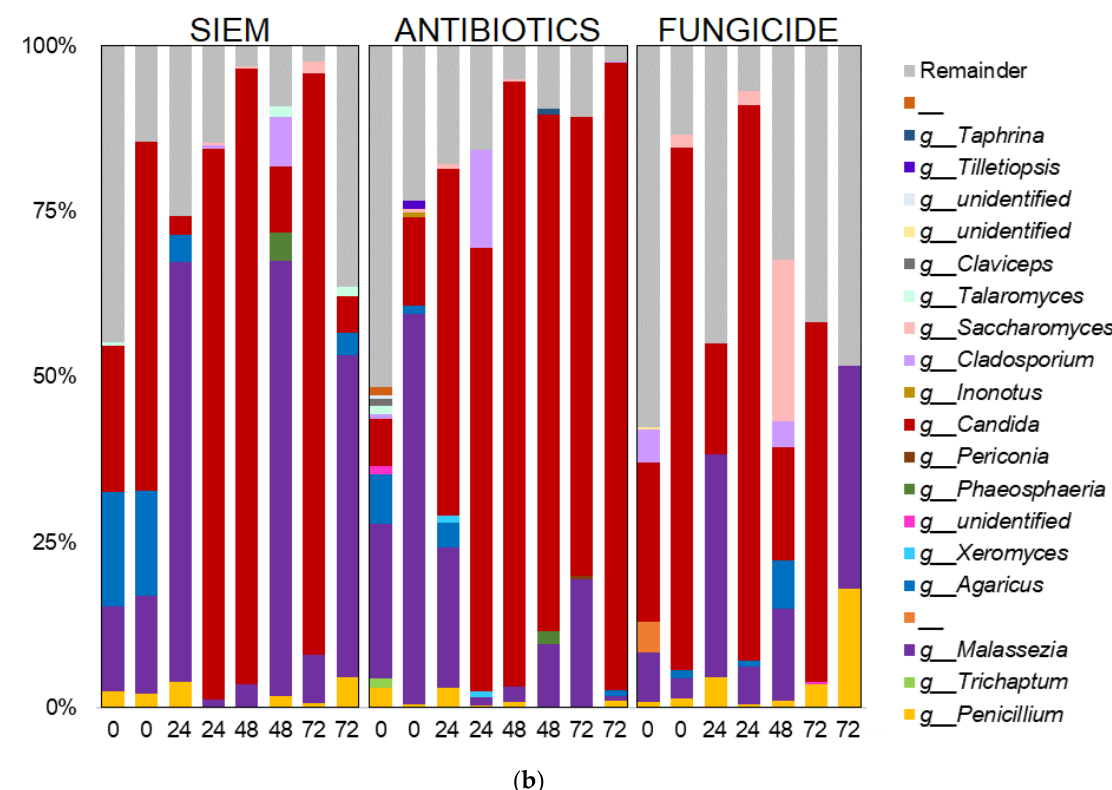
Figure 7. Taxonomic classification of fungi at ( a ) phylum and ( b ) genus level.